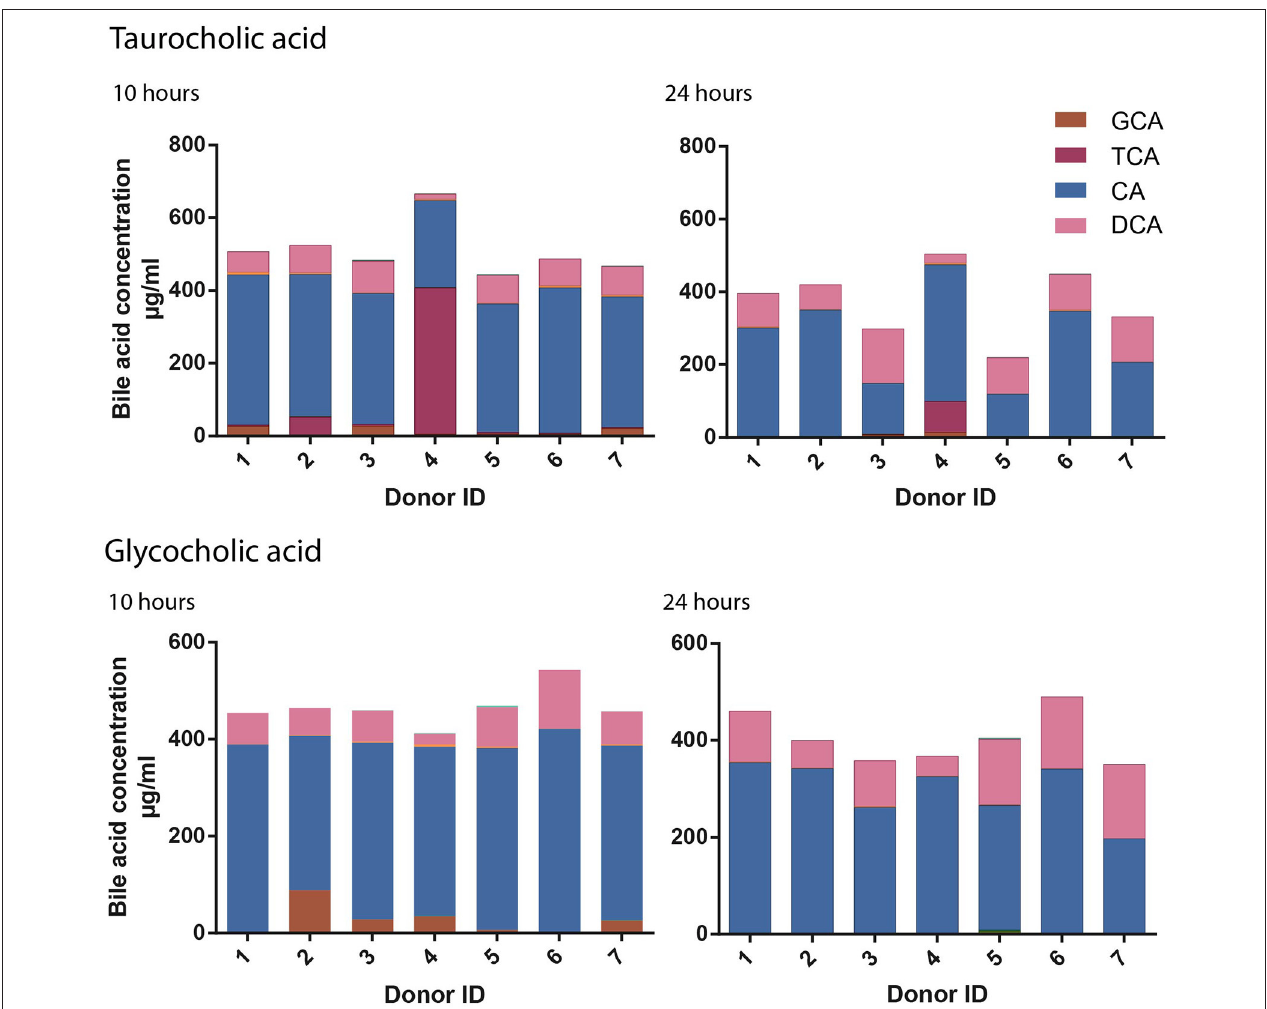
FIGURE 4 | Inter-individual variation in cholate conjugated metabolism. Fifteen bile acid moiety concentrations were quantified by UPLC-MS for each donor ( n = 7) at 0, 5, 10, and 24h. The rate of taurocholic acid (TCA) and glycocholic acid (GCA) deconjugation was slower for Donor 4 and Donor 2 respectively at 10 and 24h post treatment with primary conjugated cholic acid